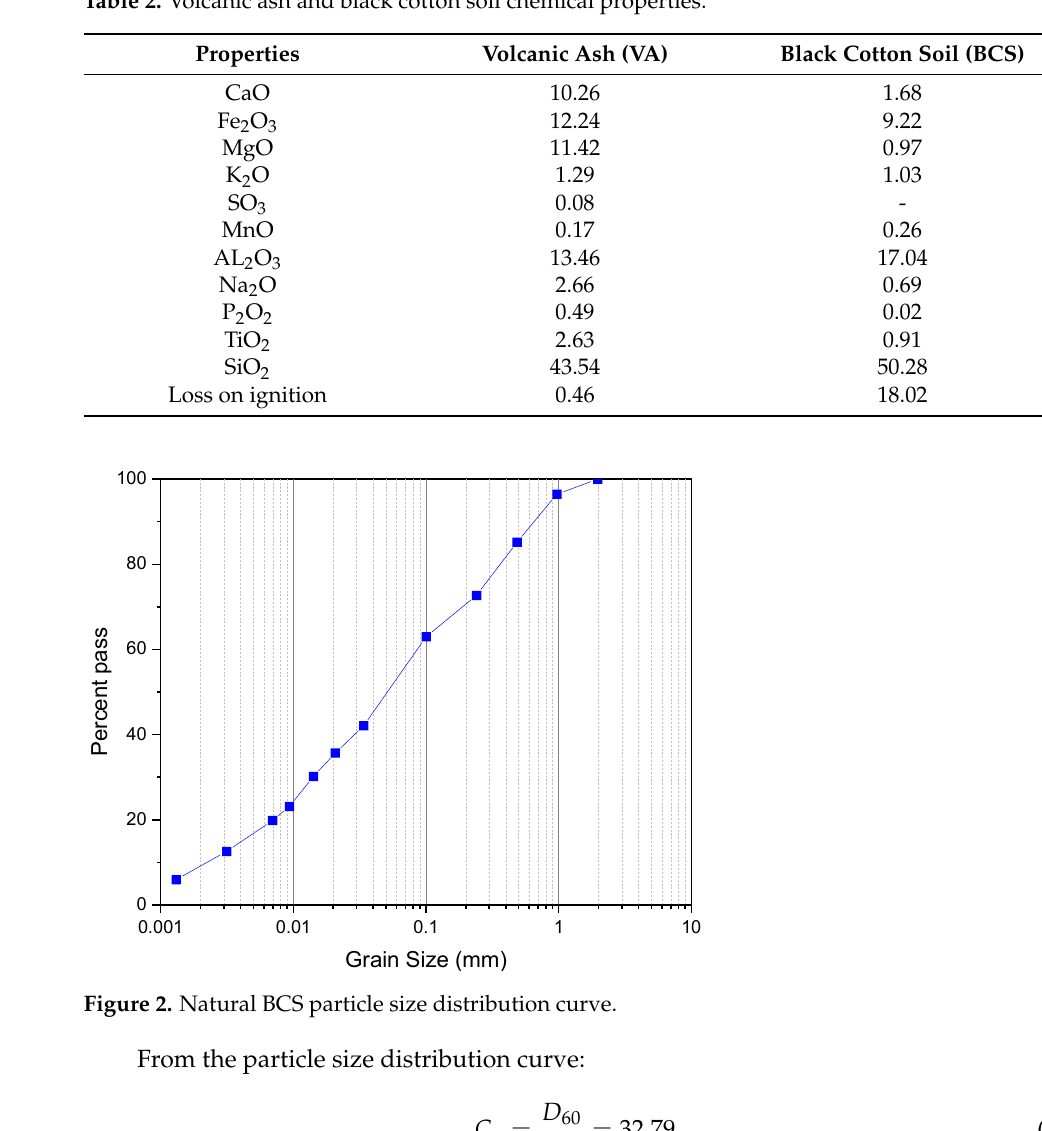
Table 2. Volcanic ash and black cotton soil chemical properties.